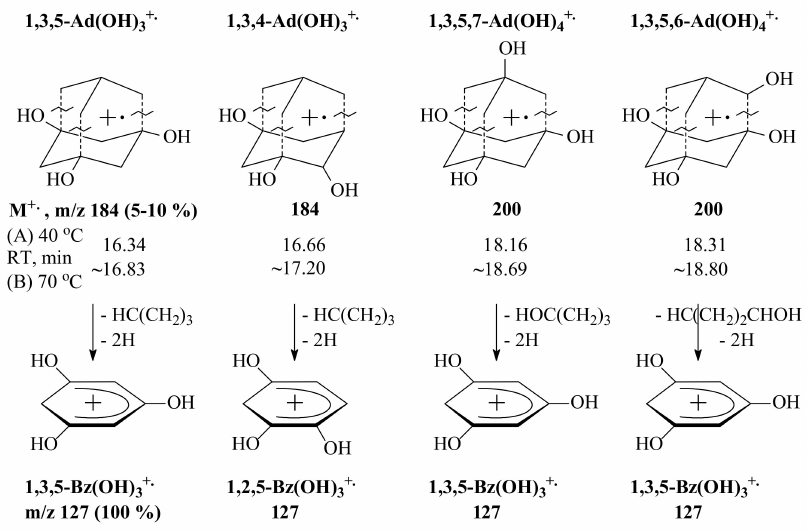
Scheme 4. Fragmentation of molecular ions of 0 tri- and